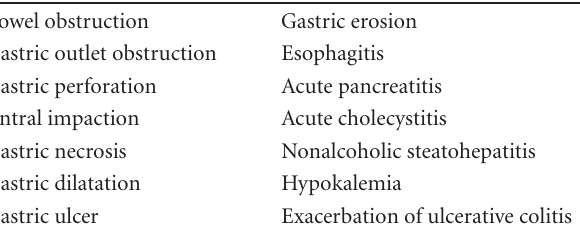
Table 2: Reported balloon complications presenting with abdomi- nal